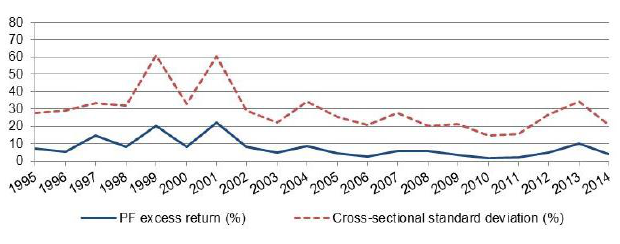
Figure 3: Large Cap segment PF excess return and cross-sectional standard deviation